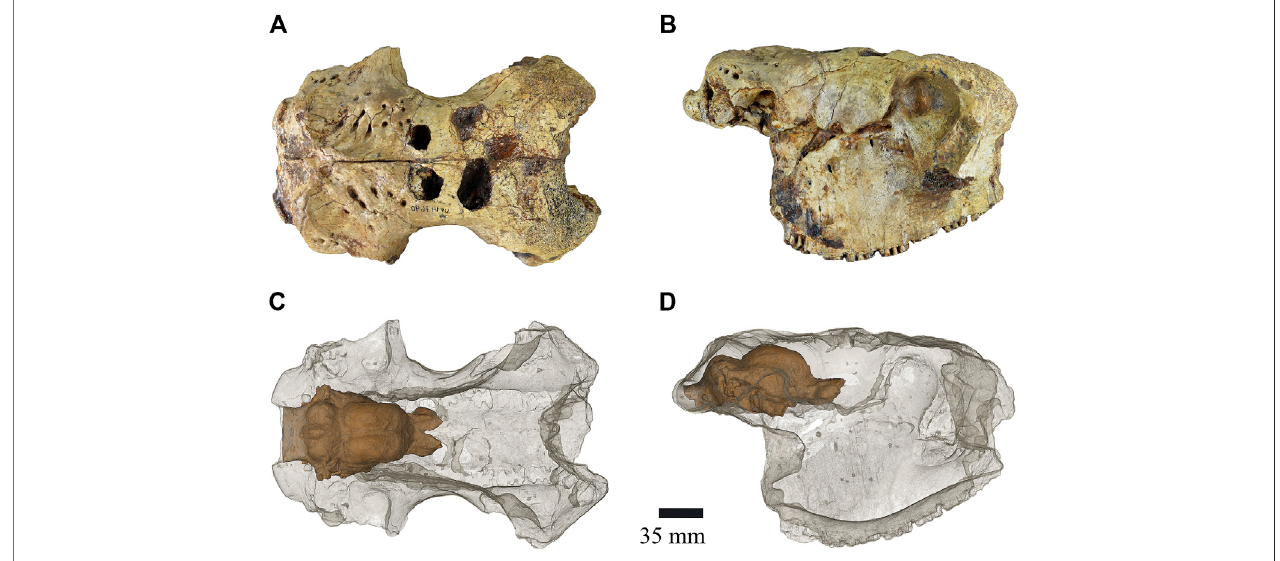
FIGURE 4 | Physical (A,B) and virtual (C,D) Glyptodon sp. skull (UF-VP-147690) in dorsal (A,C) and right lateral (B,D) views, anterior to the right, with endocranial cast highlighted in orange. Scale (cid:1) 35 mm.